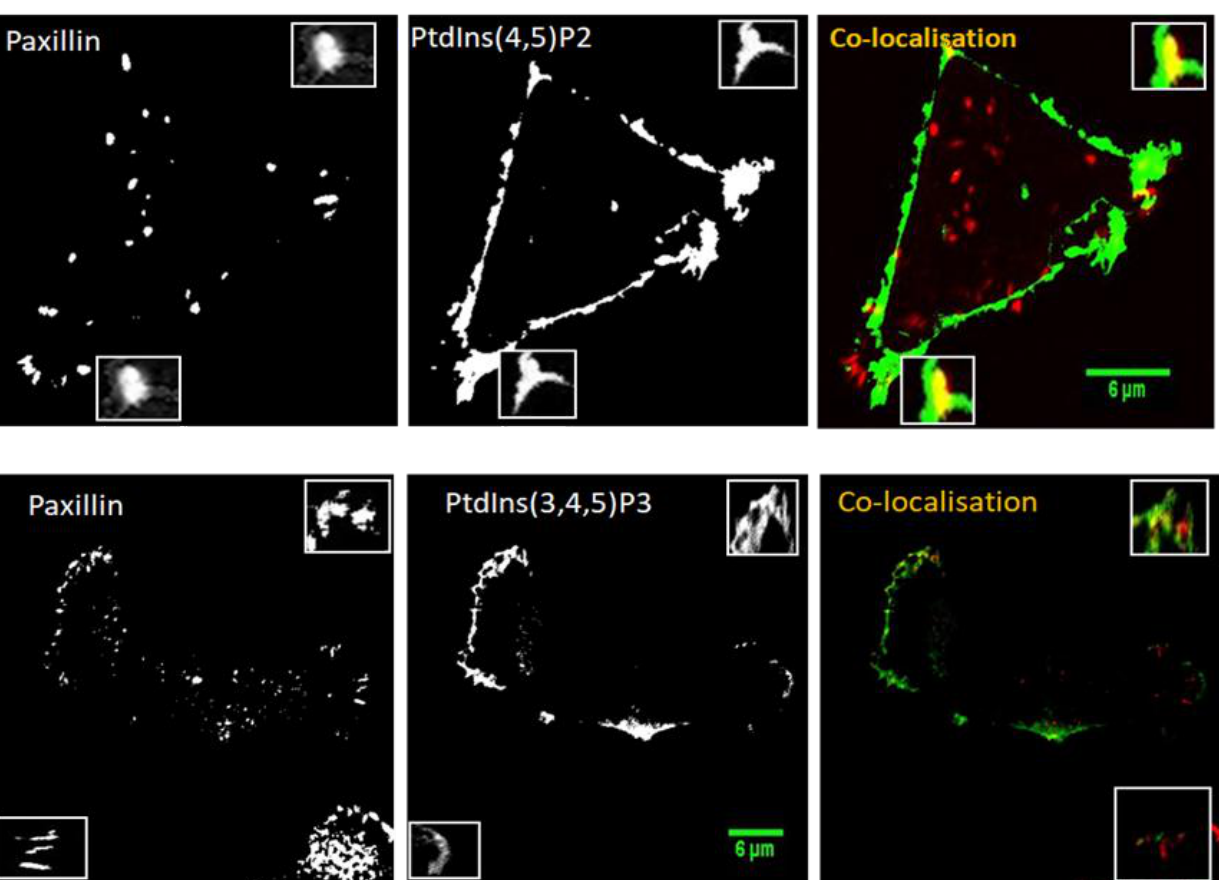
Figure 1 : Spatial co-localisation between PtdIns(4,5)P2/ PtdIns(3,4,5)P3 and paxillin at the leading and trailing edges of MDA- MB-231 cells on variety of surfaces .Cells were plated on collagen 2mg/ml and co-transfected with PLC  1-PH-GFP/ Btk-PH-GFP (green )then fixed and immunostained for paxillin (red). The spatial interaction between PtdIns(4,5)P2/ PtdIns(3,4,5)P3 and paxillin was measured through selection ROI at the leading and trailing edges of the cell. The highlighted areas show a magnification of spatial co-localisation region between PtdIns(4,5)P2/ PtdIns(3,4,5)P3and pxillinat the leading and trailing edges. Representative picture is